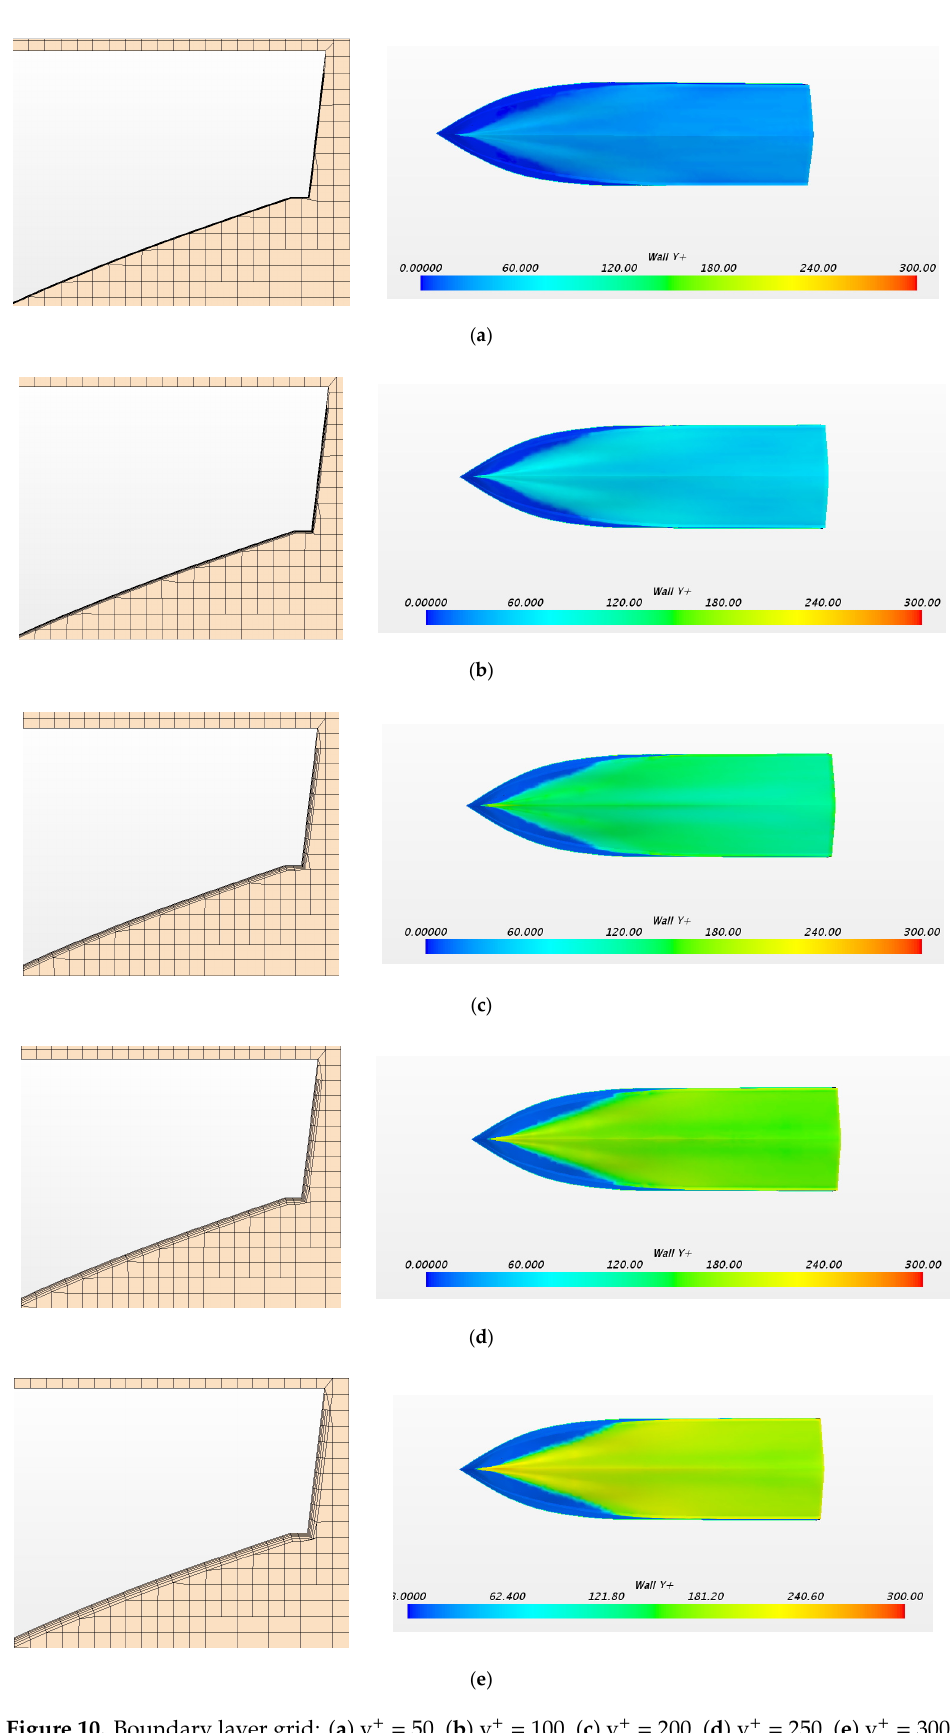
Figure 10. Boundary layer grid: ( a ) y + = 50, ( b ) y + = 100, ( c ) y + = 200, ( d ) y + = 250, ( e ) y + = 300.